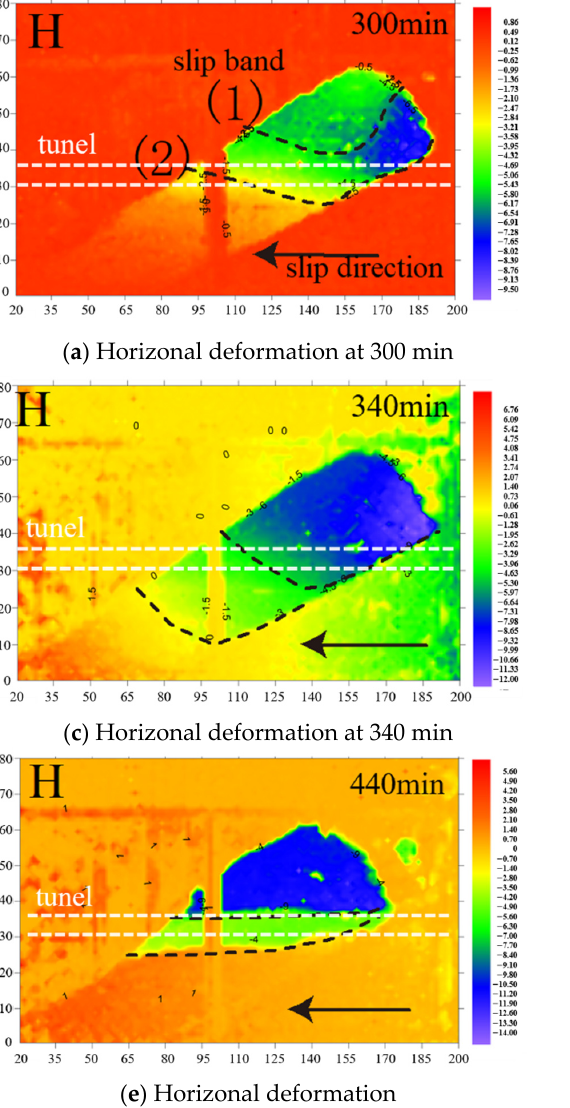
Figure 8. Lateral displacement contour measured by PIV system. (Unit: cm). At 300 min, the soil deformation was obvious. There are three deformation zones on the horizontal contour: the tunnel roof, the tunnel bottom, and the loess-bedrock interface. These deformation zones determine the deformation of the entire slope. The maximum deformation in the horizontal direction was 8 cm, and the deformation in the vertical direction was 3.8 cm, indicating that the soil moved horizontally under the action of trailing edge pressure. The slope above the tunnel presented progressive failure characteristics, and the deformation decreased gradually from the back edge to the